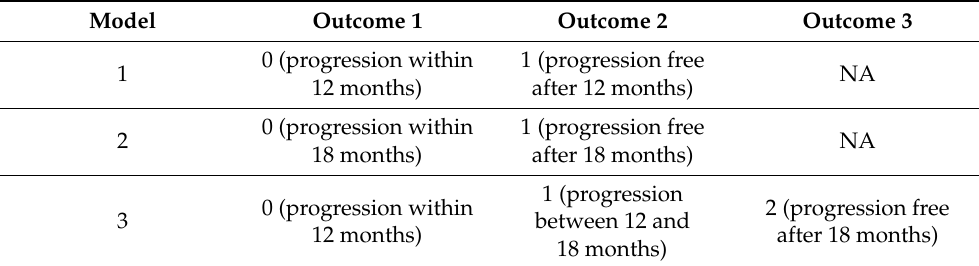
Figure 1. Plots of the count of samples per class. From the left: model 1–PFS 12 months, model 2—PFS 18 months, model 3—PFS. Table 1. Meaning of outcomes in each